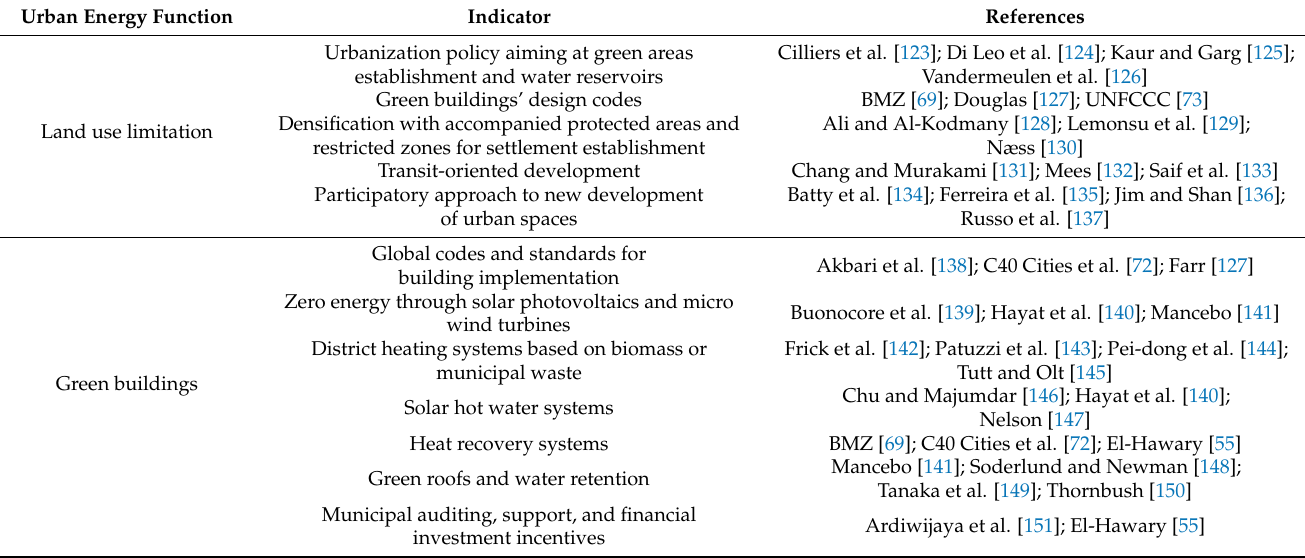
Table A2. Urban energy function initiatives for the reduction in GHG emissions from